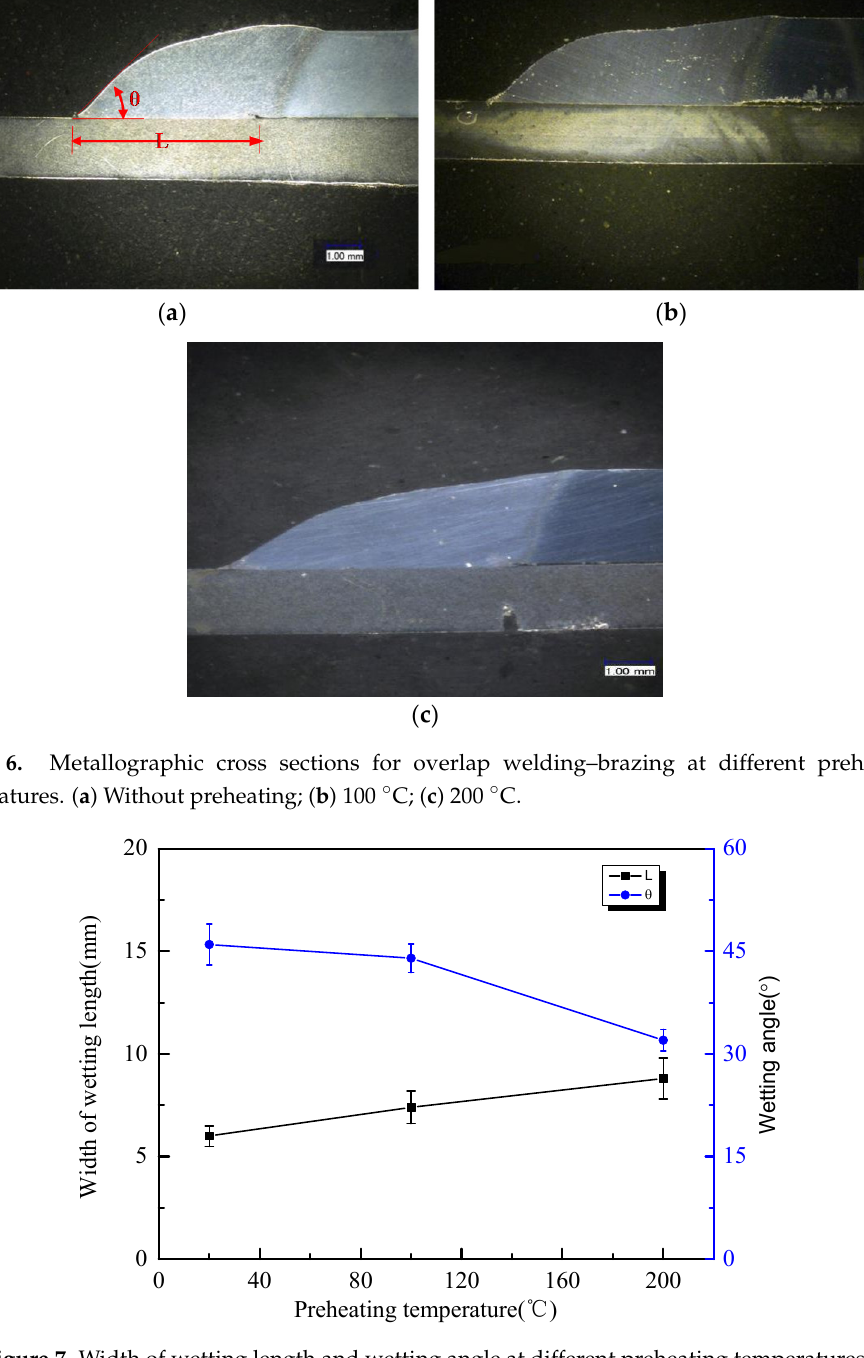
Figure 7. Width of wetting length and wetting angle at different preheating temperatures.